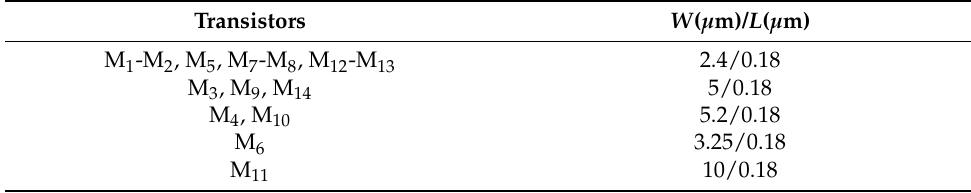
Figure 2. Possible CMOS realization of the VDBA. Table 3. Transistors’ aspect ratios in Figure 2.